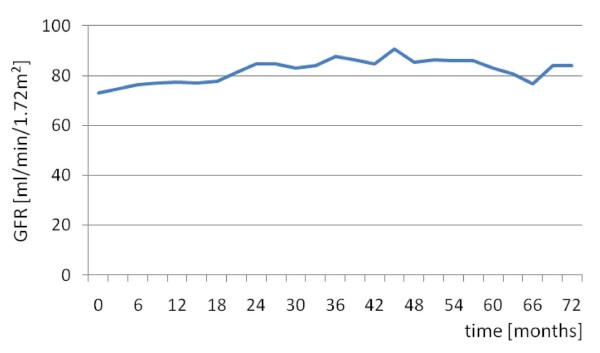
GFR values during follow-up.